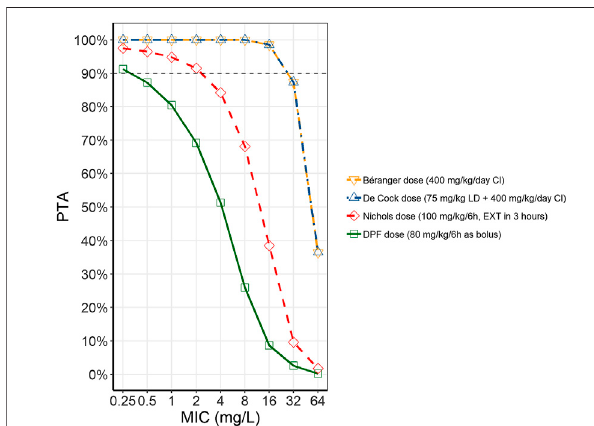
FIGURE 2 | Probability of target attainment (PTA) for piperacillin with different dosing regimens. The different lines represent the average PTA across the three models at different MICs for the different dosing regimens (Béranger dose (cid:1) yellow, dashed line, downward facing triangle; De Cock dose (cid:1) blue, dash-dotted line, upward facing triangle; Nichols dose (cid:1) red, dashed line, diamonds; DPF dose (cid:1) green, solid line, squares). (CI, continuous infusion; DPF, Dutch Pediatric Formulary; EXT, extended infusion; LD, loading dose; MIC, minimum inhibitory concentrations).